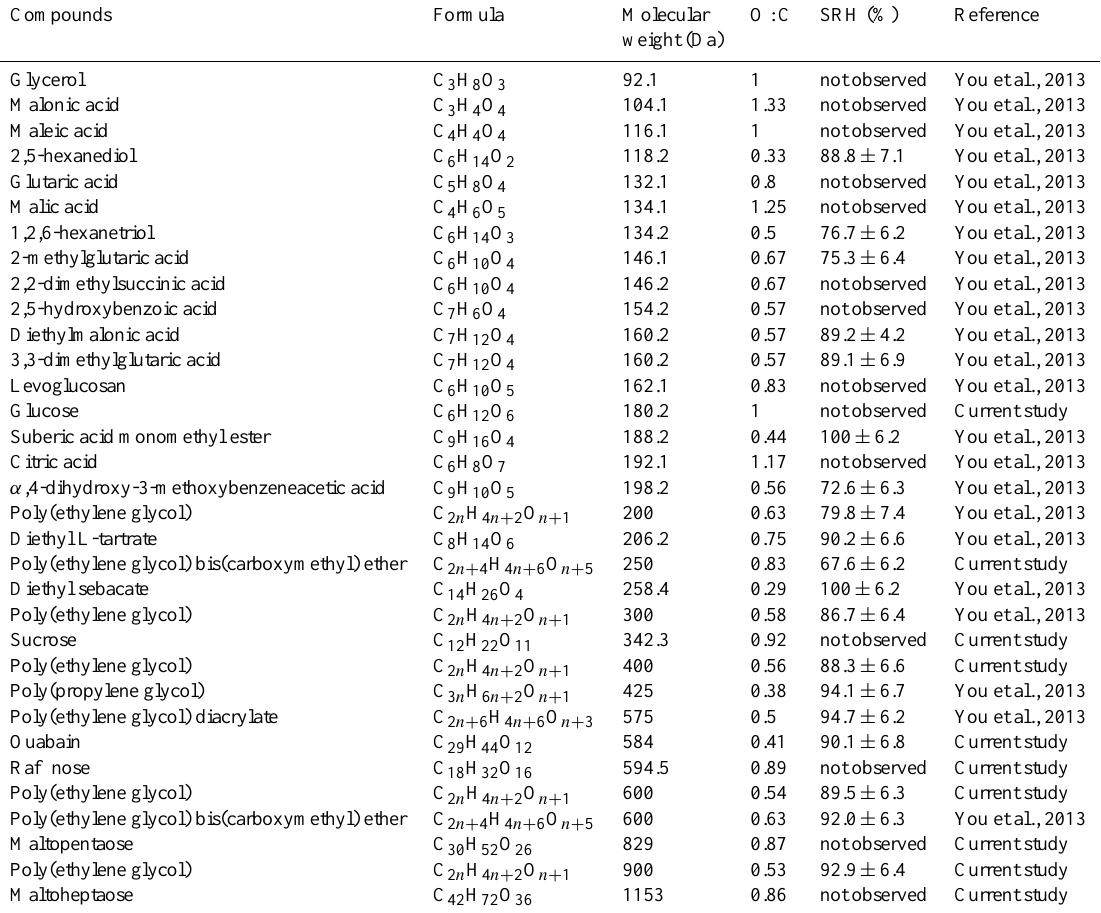
Table 3. Combined data set used to assess the effect of molecular weight on SRH in mixed organic–ammonium sulfate particles. This data set includes the 10 types of particles studied here (see Table 1) and the SRH results of 23 types of particles containing single organic species and ammonium sulfate studied by You et al. (2013). OIR = 2.0 ± 0.1 in all the experiments. Uncertainties are 95% confidence intervals considering σ of multiple SRH measurements and the uncertainty from the